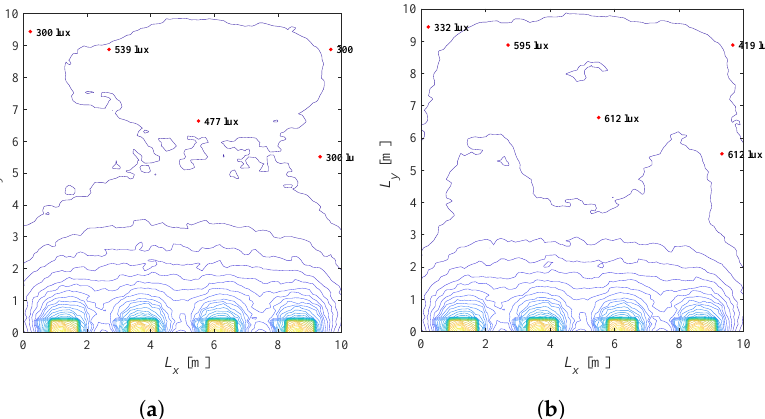
Figure 17. Solution of the Problem 4 defined in (22), K = 5 users located opposite of the windows, Φ = 60 0 . ( a ) λ = 0.01, a = 1, G = 0.32. ( b ) λ = 0.5, a = 1, G = 1/2